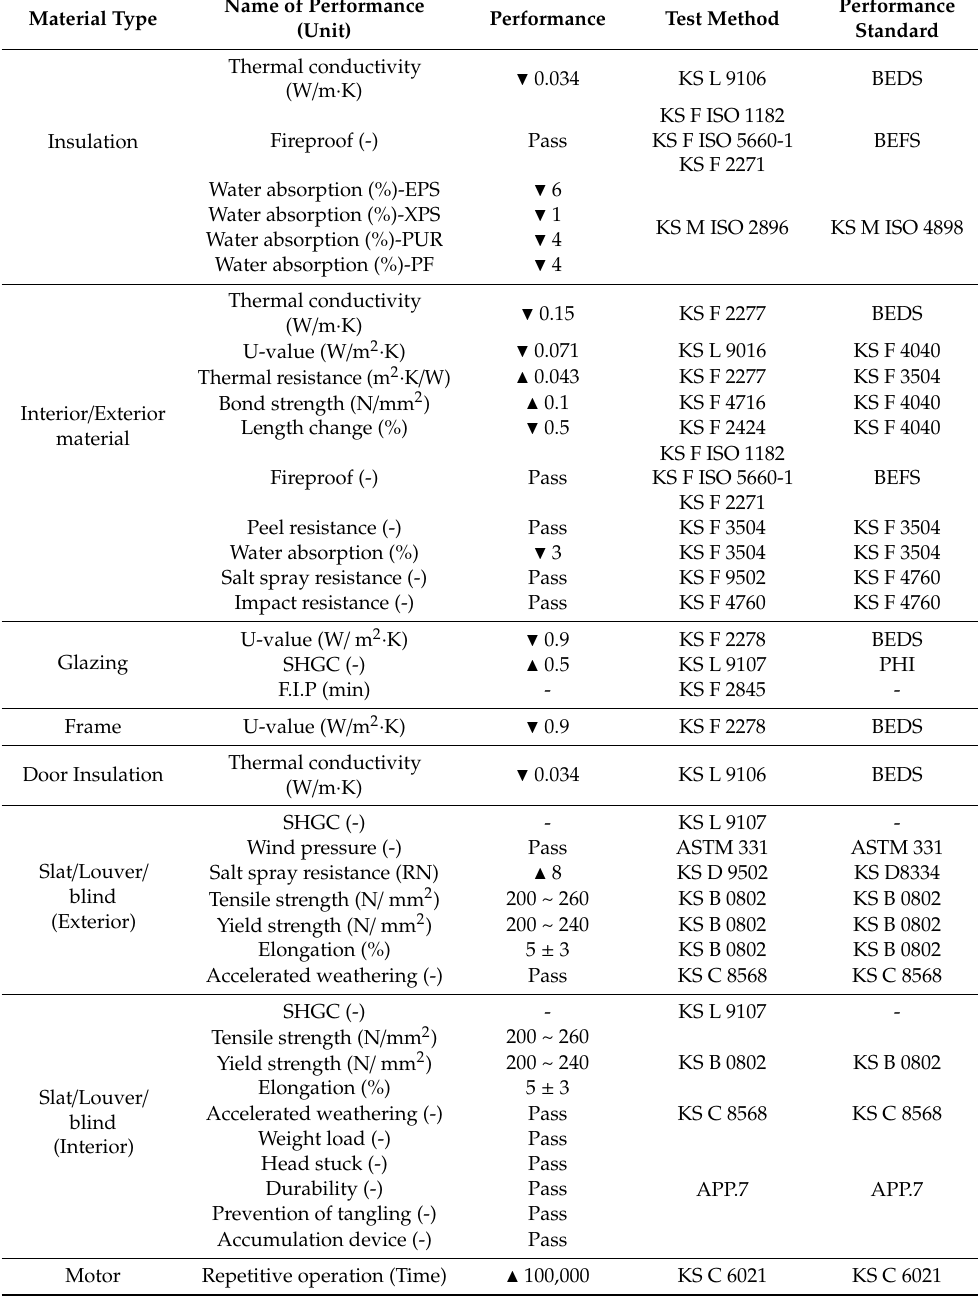
Table 4. Test methods and performance reference of the